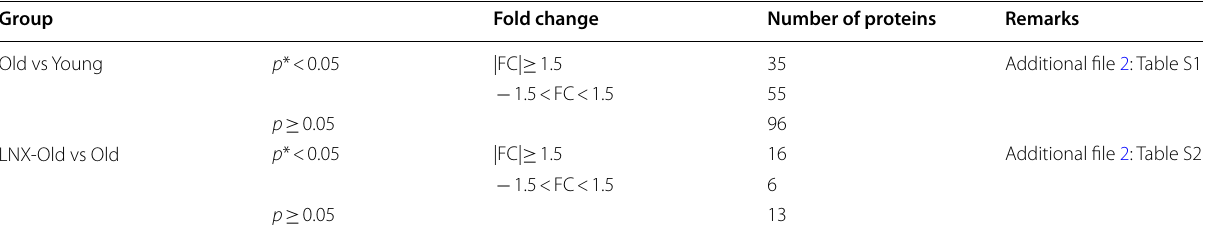
Table 1 Summary of quantitative proteome analysis. Data are presented in three groups: muscles of young, old, and LNX (100 mpk)‑ fed old mice Group